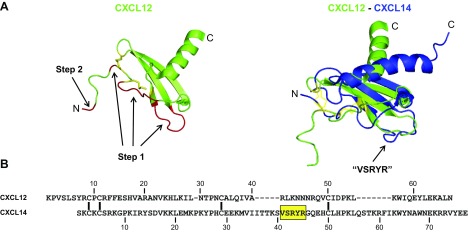
Primary and tertiary structure comparison between CXCL14 and CXCL12. A) Ribbon diagrams of CXCL12 alone (left; UniProt P48061) and in combination with CXCL14 (right; UniProt O95715). Step 1 and step 2 indicate regions that are shown to be involved in binding to CXCR4 (step 1) and induction of signal transduction (step 2). Diagrams were computed by using PyMOL. B) Single amino acid sequence alignment of mature human CXCL12 and CXCL14. Position of conserved Cys residues are shown by vertical bars; yellow box highlights the extended 40s-loop region in CXCL14.